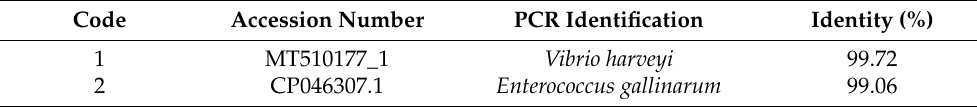
Table 2. Homology searches for 16S rRNA sequences of the bacterial isolates in GenBank.